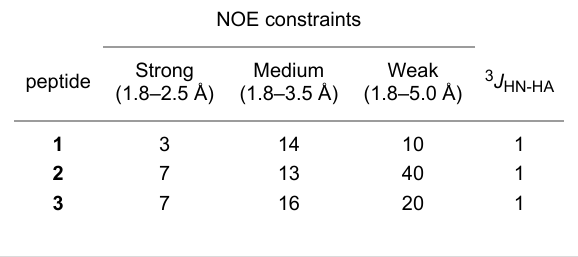
Table 2: Number of structural constraints used during